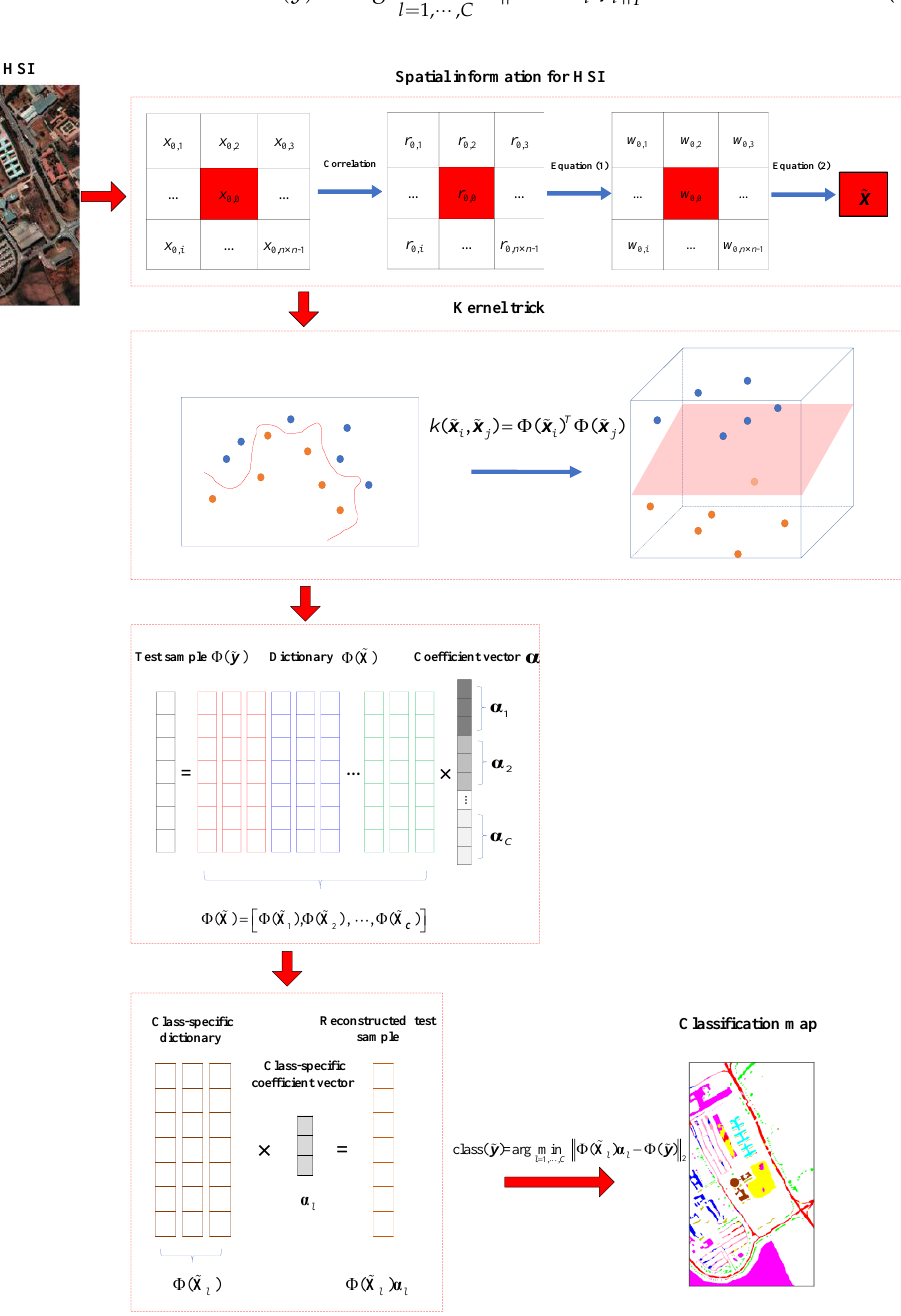
Figure 1. The flowchart for the WSSKCRT method. The flowchart for the JCRC method is shown in Figure